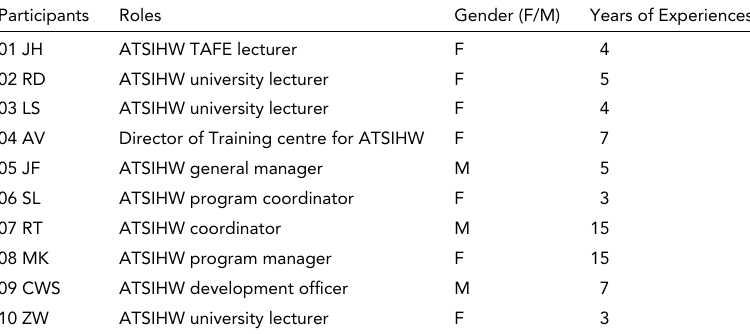
Participants by Role, Gender and Years of